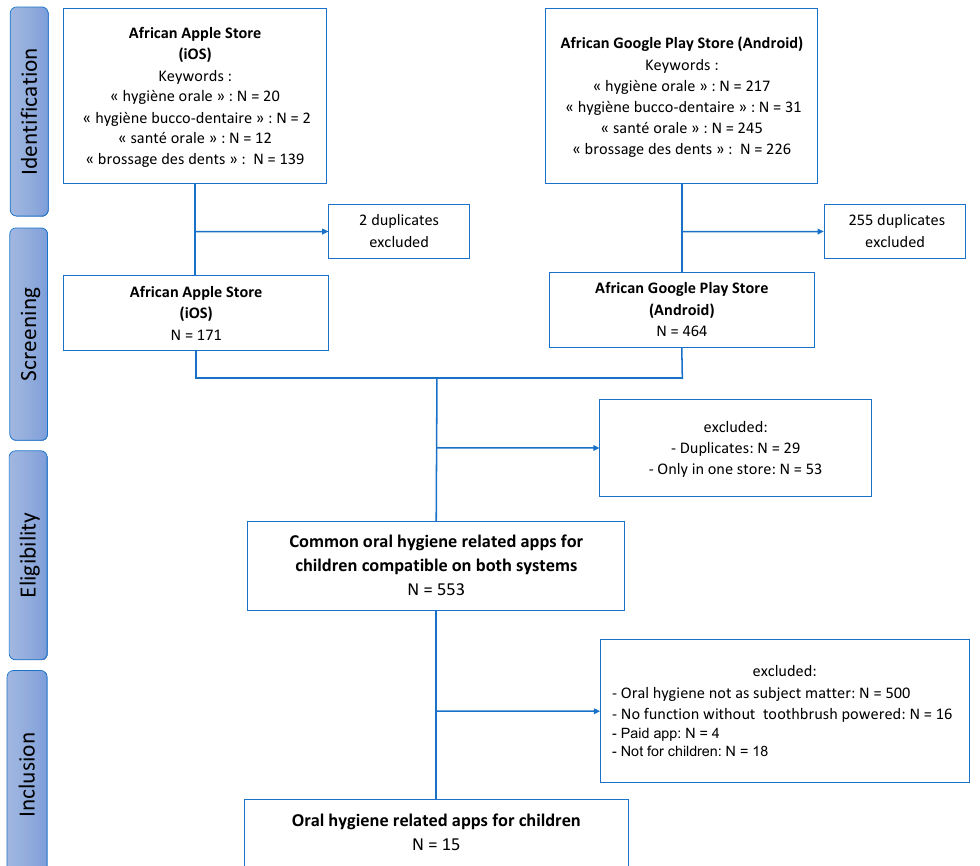
Figure 1. Flowchart of the section of oral hygiene-related mobile applications for children available in Sub-Saharan Africa. Table 1. Description of the twenty oral hygiene-related mobile applications for